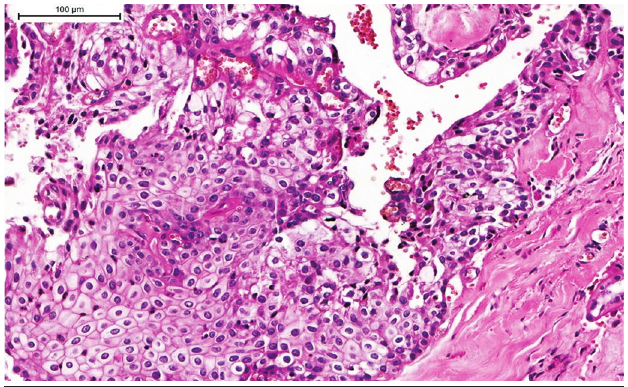
figurE 3 − Histological examination of the specimen revealed a neoplasm composed predominantly of nests of epidermoid cells with intermediate differentiation in a fibrous stroma